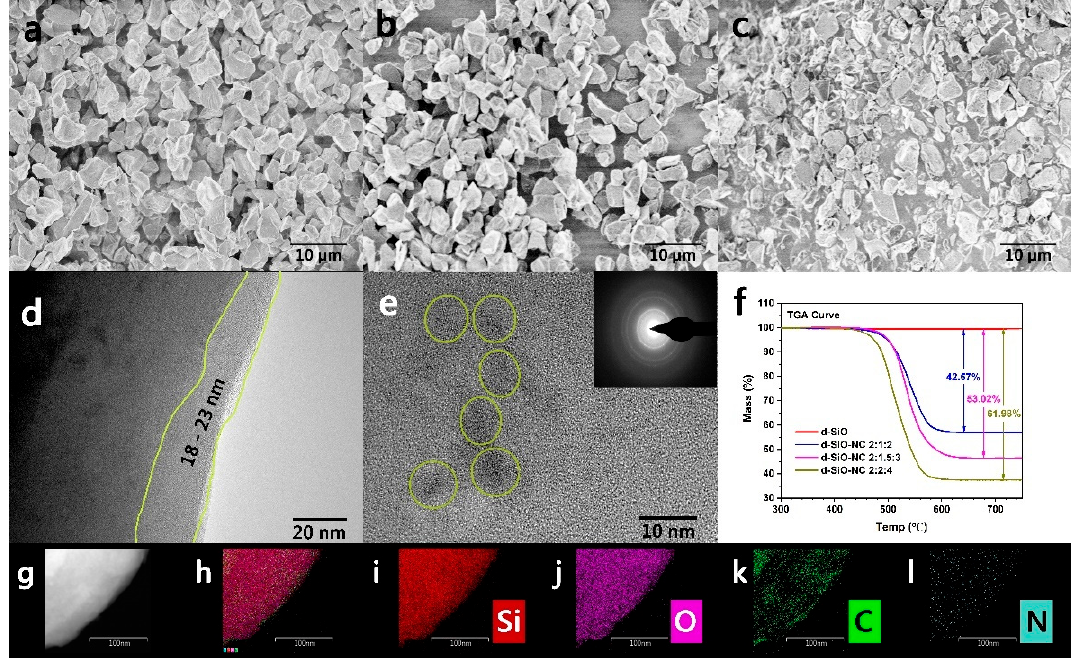
Figure 3. SEM patterns of pure SiO ( a ), d-SiO ( b ) and d-SiO-NC (2:1.5:3) ( c ). ( d ) TEM images of the coating layer of d-SiO-NC (2:1.5:3). ( e ) TEM images of the inner part of d-SiO-NC (2:1.5:3) with the corresponding lattice spacing. ( f ) TG curve of d-SiO-NC (2:1.5:3) with different ratio of raw materials. ( g – l ) Element mapping images of d-SiO-NC (2:1.5:3) (Scale bar: 100 nm). Table 1. The content of d-SiO, N and C in three kinds of prepared d-SiO-NC materials. d-SiO:Melamine:Pitch